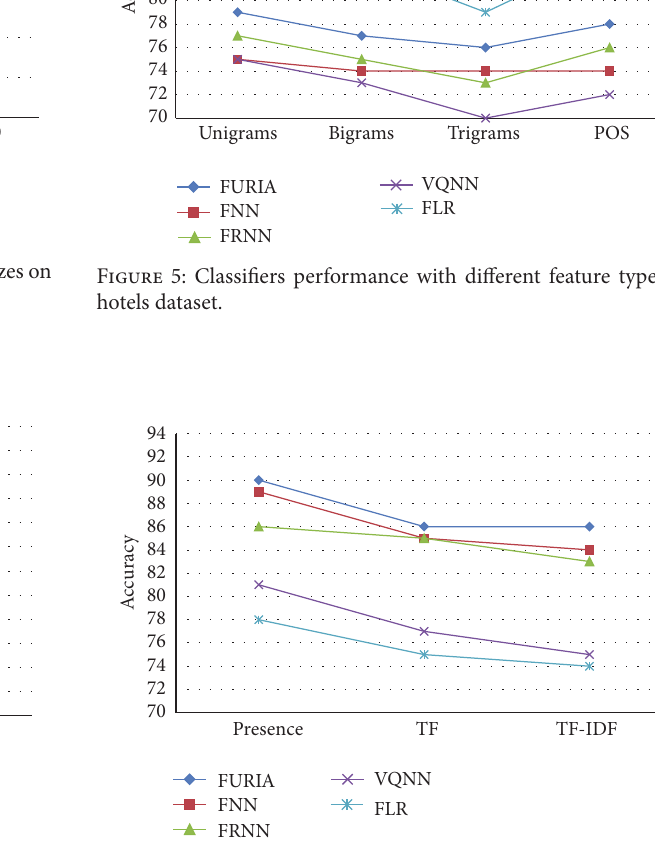
Figure 4: Classifiers performance with different feature types on restaurants dataset.